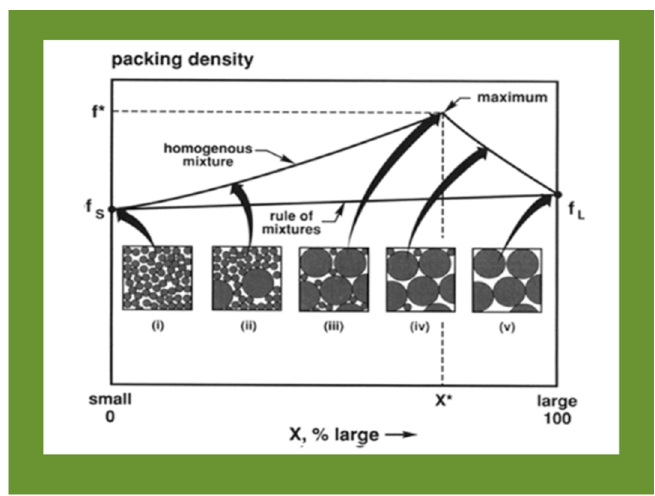
Figure 3. Relationship between packing density and particle size [46].